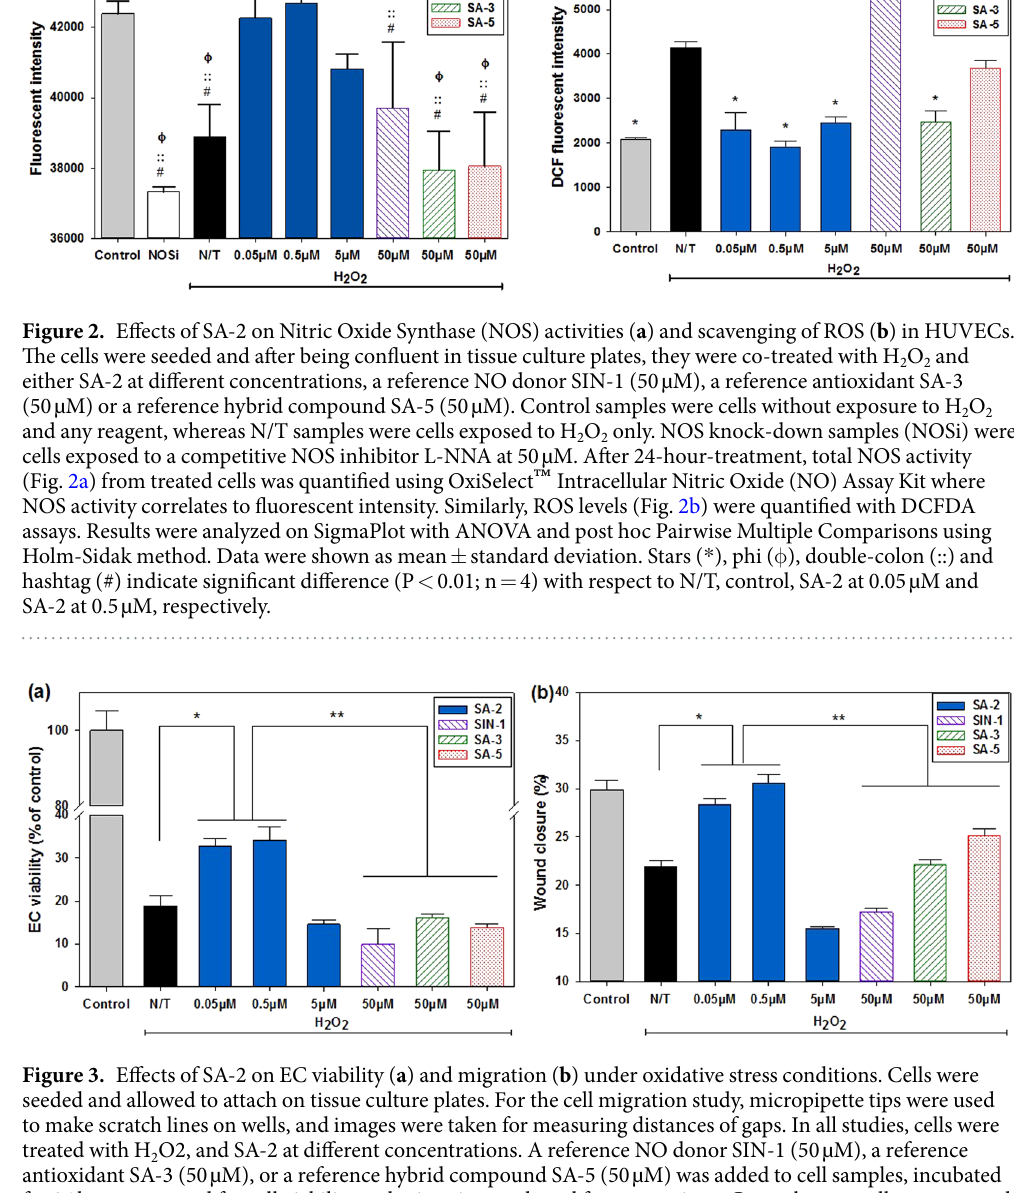
Additionally, the hybrid compound SA-2 at concentrations ranging from 0.05 μ M–5.0 μ M effectively scavenged the excess ROS produced and maintained the redox status similar to the control (Fig. 2b), while the reference antioxidant SA-3 needed 10- to 100-fold more concentration to achieve such effects. We also noticed that the reported NO donor antioxidant hybrid SA-5 is less effective in decreasing the ROS level. Dysfunction of ECs resulting from oxidative stress is a major contributor of impaired vascular endothelial growth factor (VEGF) production and new vessel formation. With the ability to maintain NO and ROS at the physiological level, compound SA-2 with EC 50 of 0.354 μ M (Supplementary Fig. S1) protected HUVECs from H 2 O 2 -induced oxidative stress, demonstrating the increase in cell viability, whereas SIN-1, which produced the elevated NO and ROS levels in vitro , turned out to induce more cell death (Fig. 3a). Additionally, as shown in Fig. 3b, there is good correlation between SA-2 and EC functions as shown in wound closure assessments (detail images shown in Supplementary Fig. S2) in the migration study and the cytoprotection study of HUVECs